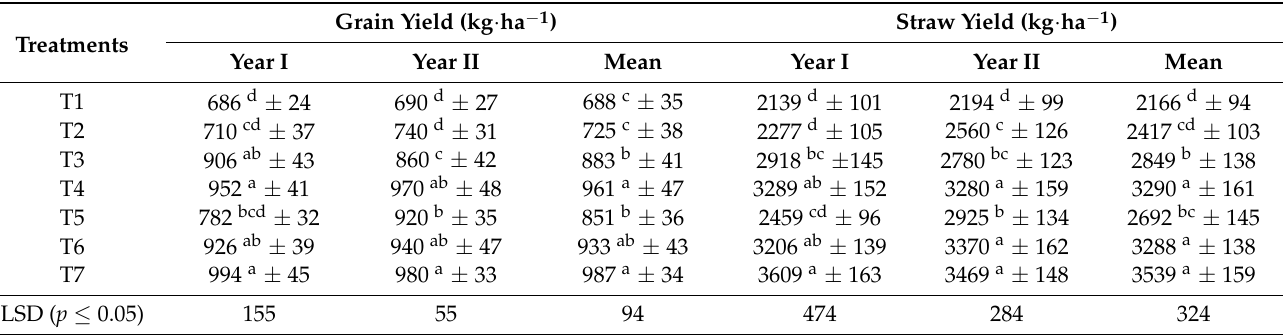
Table 2. Effect of biofortification on grain and straw yield of